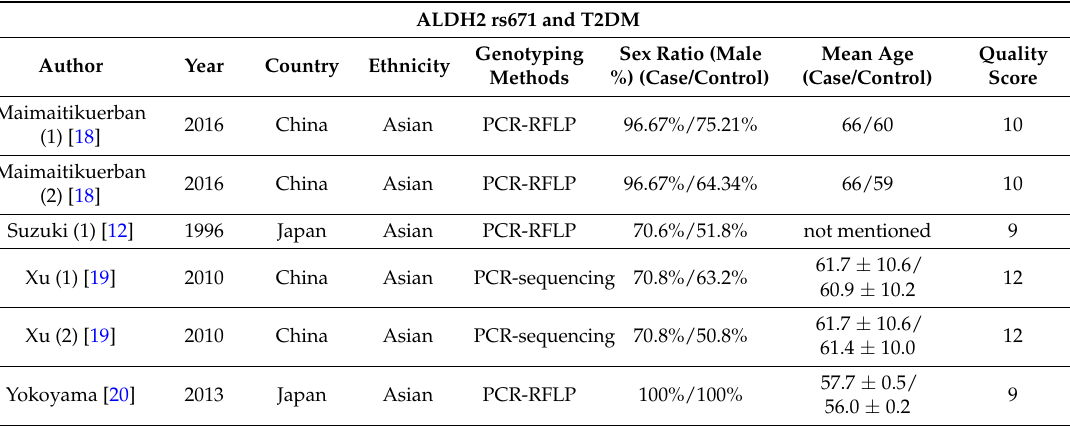
Table 1. Characteristics of eligible studies included in the